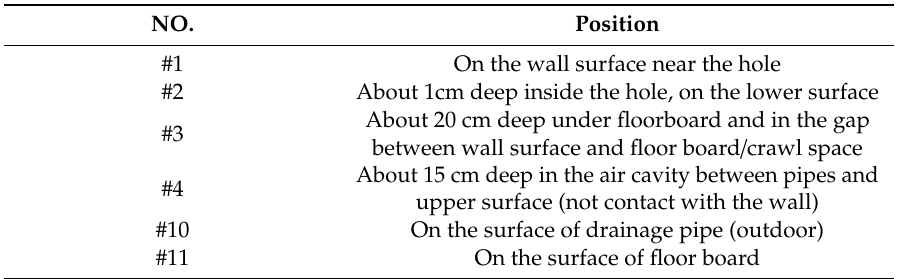
Table 2. Positions of